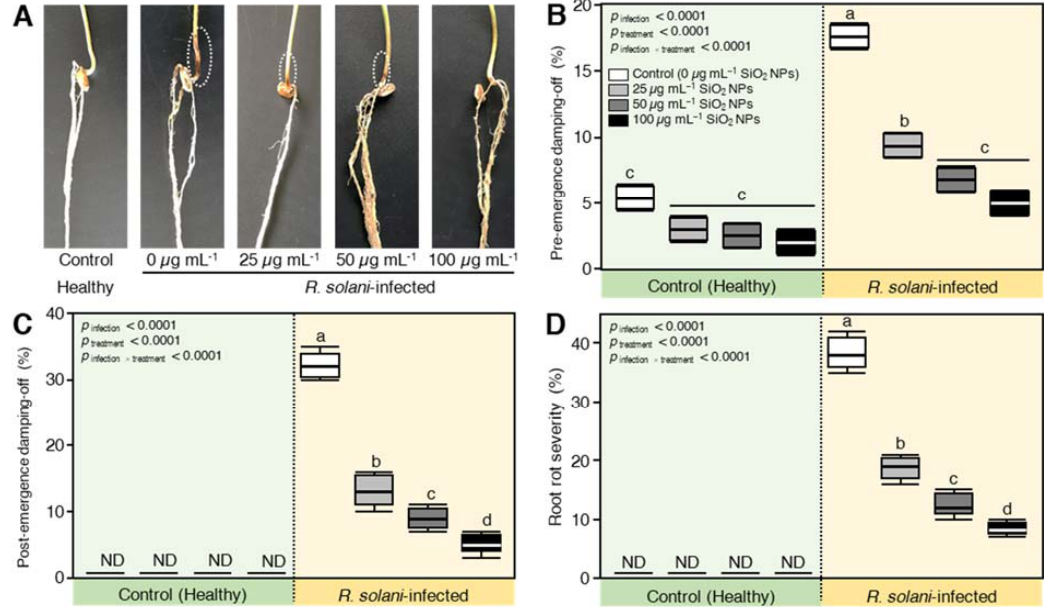
Figure 5. Effect of silicon dioxide nanoparticles (SiO 2 NPs) on damping-off severity of wheat seedlings infected by R. solani. ( A ) Healthy (negative control), R. solani -infected (positive control), and SiO 2 -treated wheat seedlings, ( B ) pre-emergence damping-off, ( C ) Post-emergence damping-off, and ( D ) Root rot severity. Whiskers show the minimum and the maximum values, horizontal thick lines indicate the medians, boxes signify the interquartile ranges (25th to 75th percentile of the data). Different letters indicate statistically significant differences among treatments, while the same letters signify no significant differences between them according to Tukey’s honestly significant difference test ( p < 0.05; n = 5).